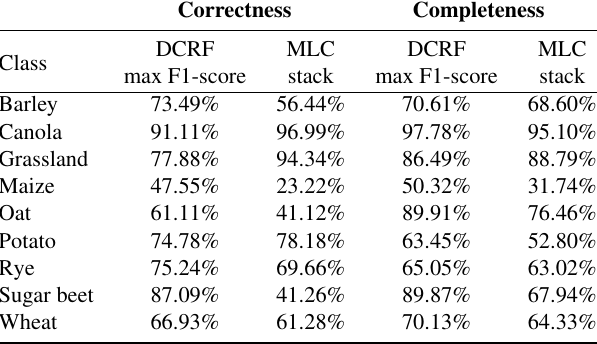
Table 3. Crop correctness and completeness accuracy measures from DCRF max F1-score and MLC stack.